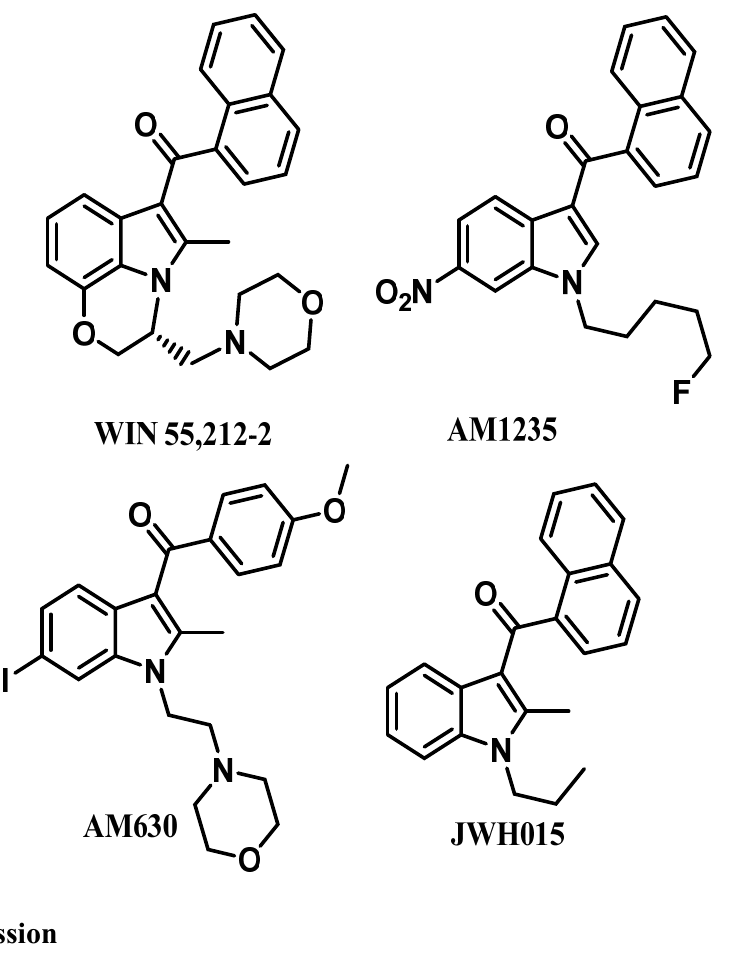
Figure 1. Representative aminoalkylindole